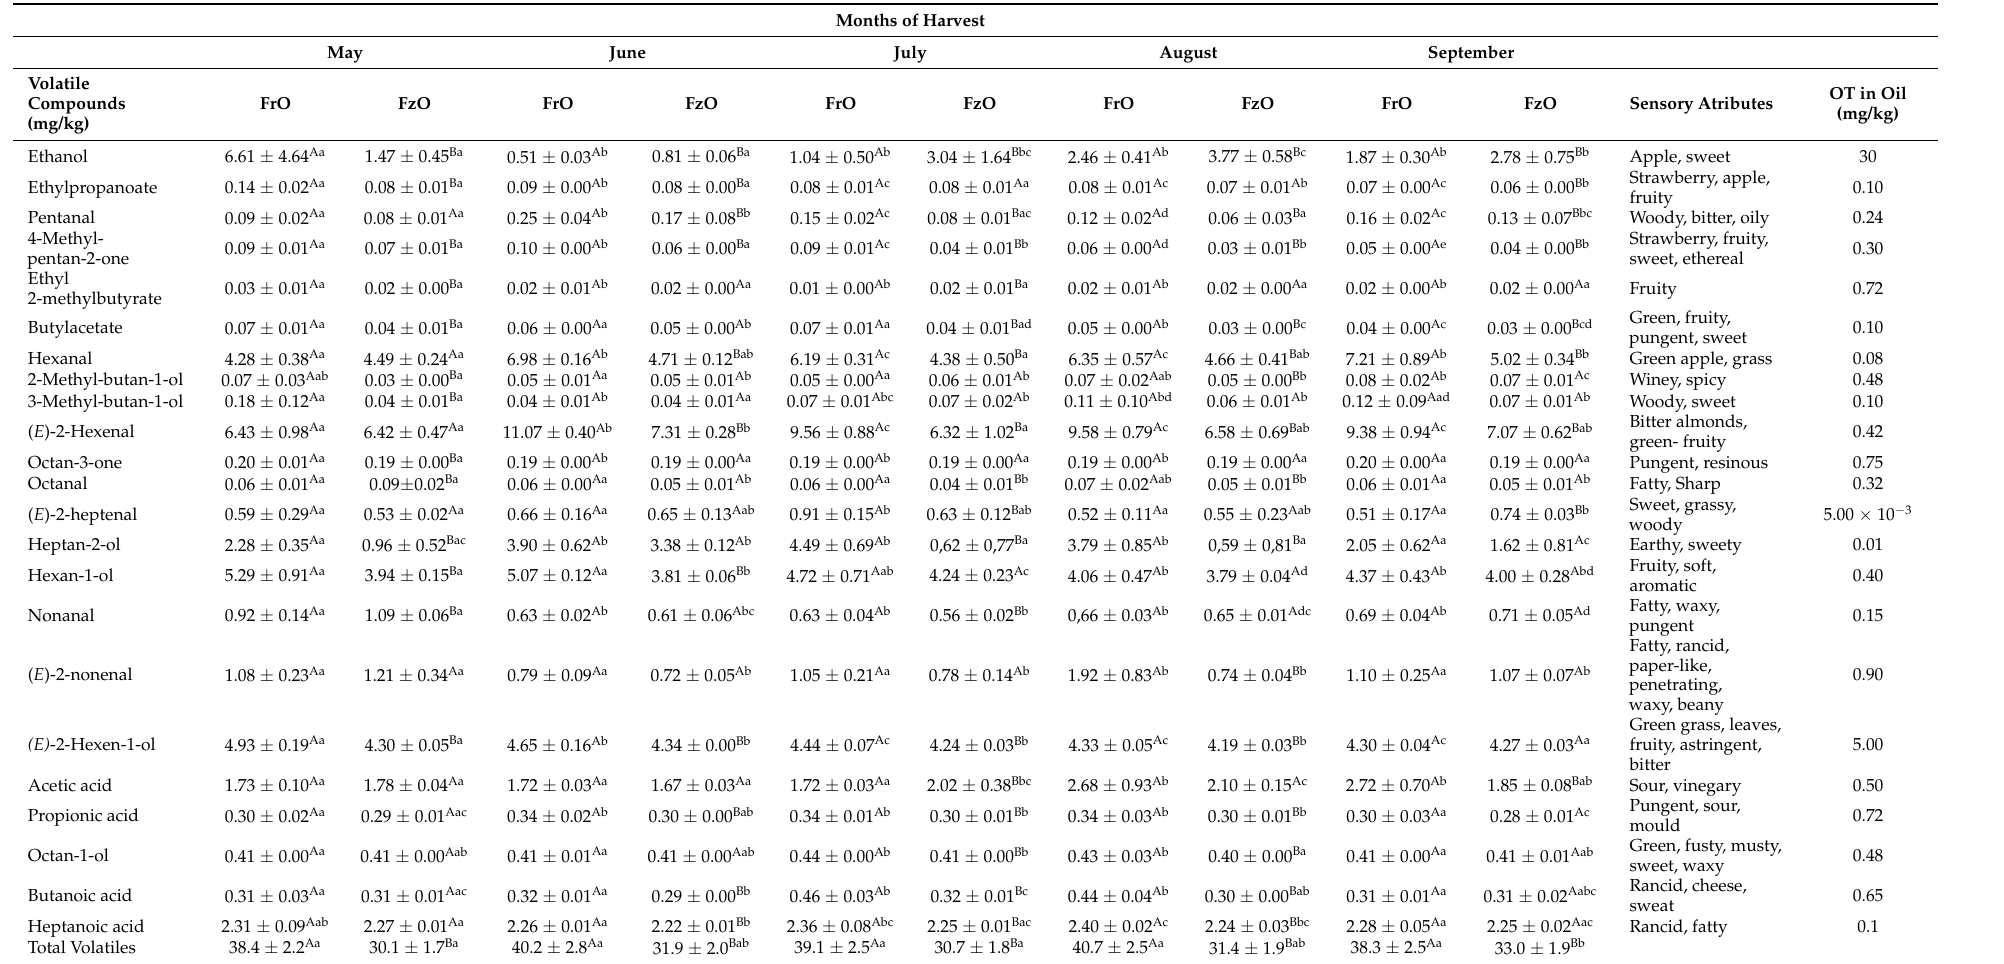
Values are mean ± SD ( n = 3). Different capital letters in the same row for each month indicate significant differences between VOO from fresh and frozen olives ( p < 0.05; LSD Fisher). Different lower-case letters in the same row indicate significant differences between oils of different ripening stages ( p < 0.05; LSD Fisher). Abbreviations: FrO, Oil from fresh olives. FzO, oil from frozen olives. OT, Odour